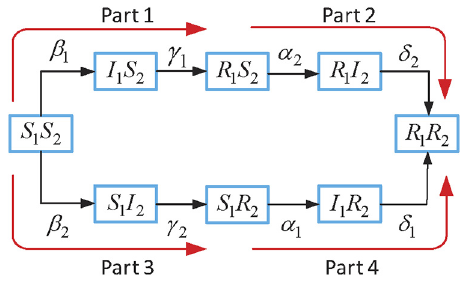
Figure 3. The state